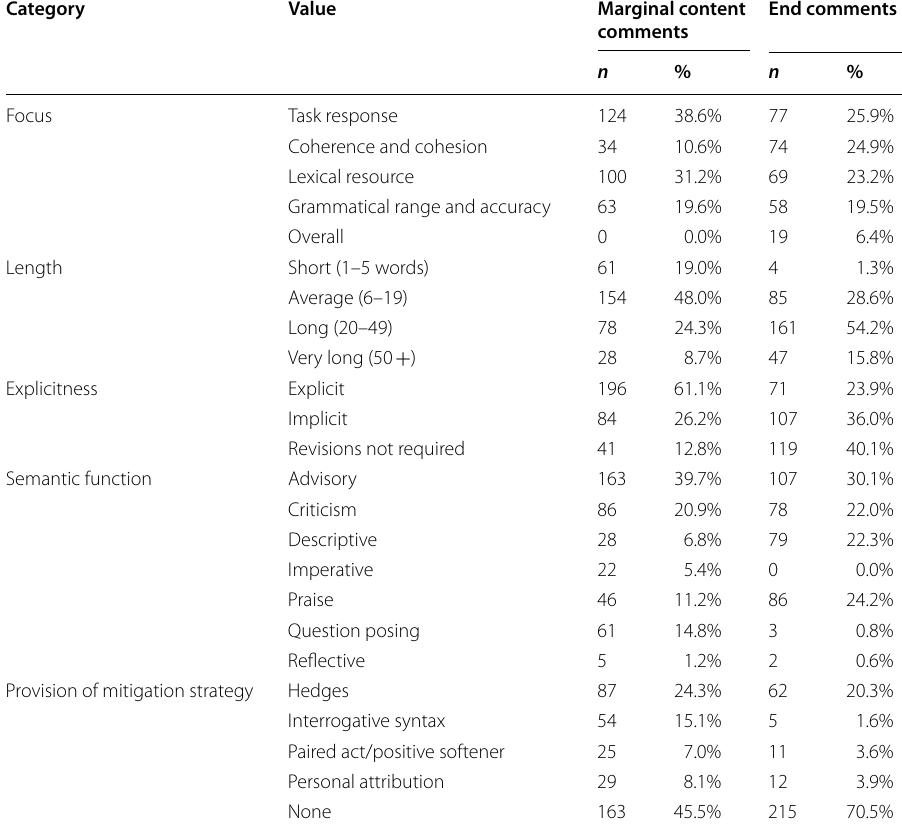
Table 2 Characteristics of teacher commentary Category Value Marginal content